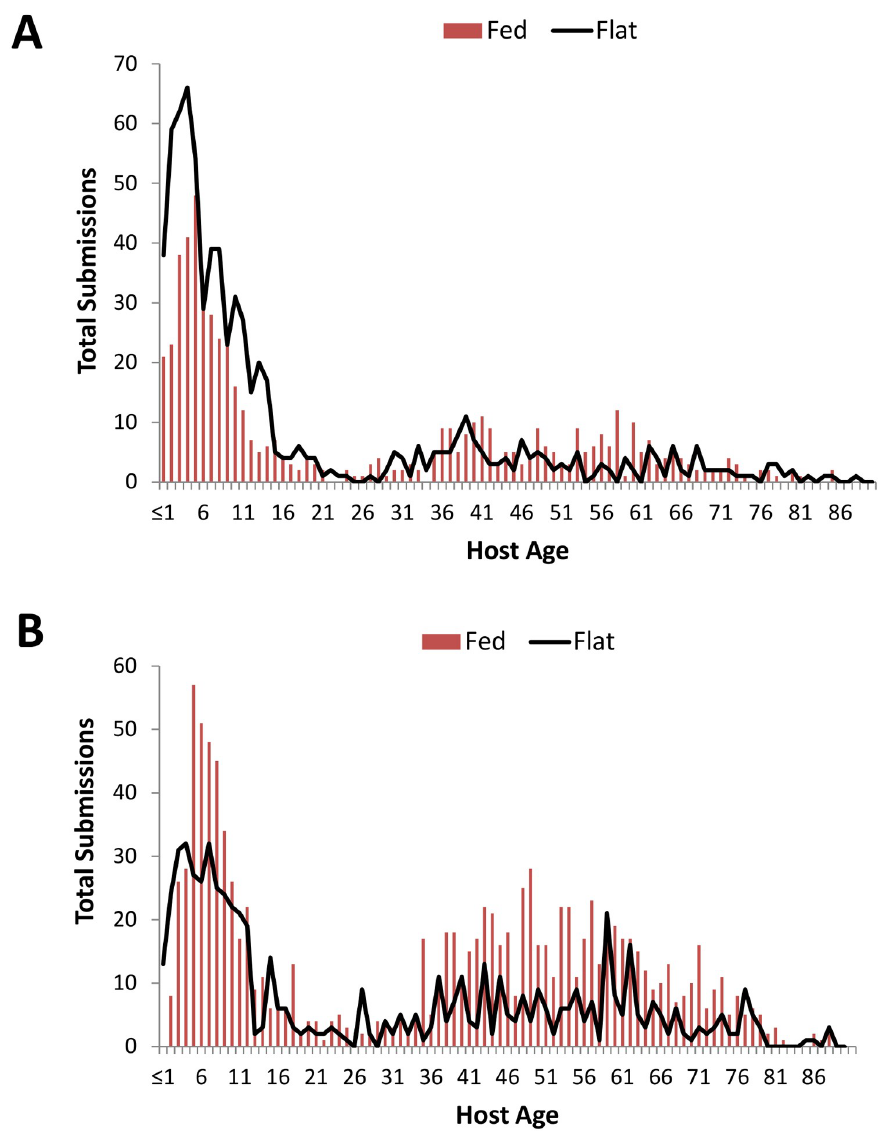
Fig 4. Differences in host age distribution of flat vs. fed ticks between tick species. A) Ixodes scapularis , B) Amblyomma americanum .